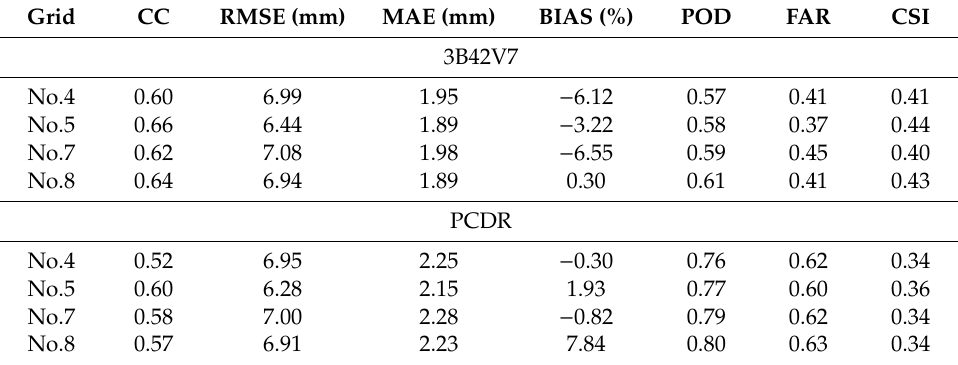
Table 1. Evaluation indices of daily 3B42V7 and PCDR products versus gauge observation from 2000 to 2015 for each